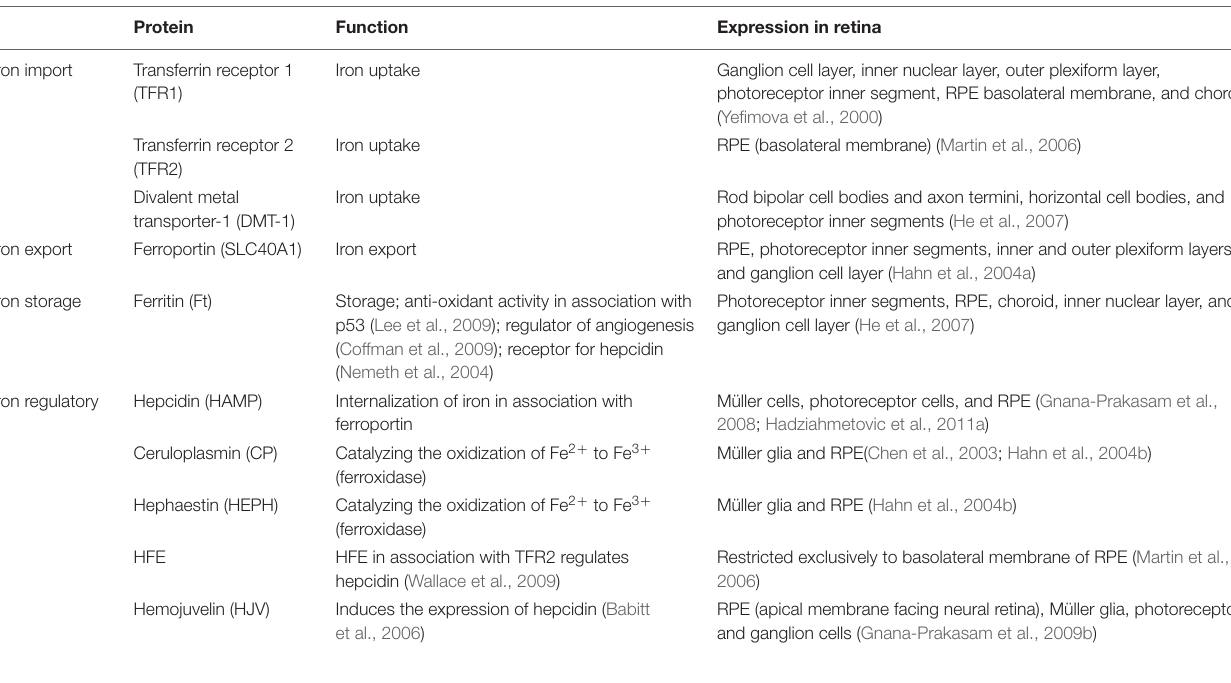
TABLE 2 | Summary of the major iron-related proteins found in the retina.